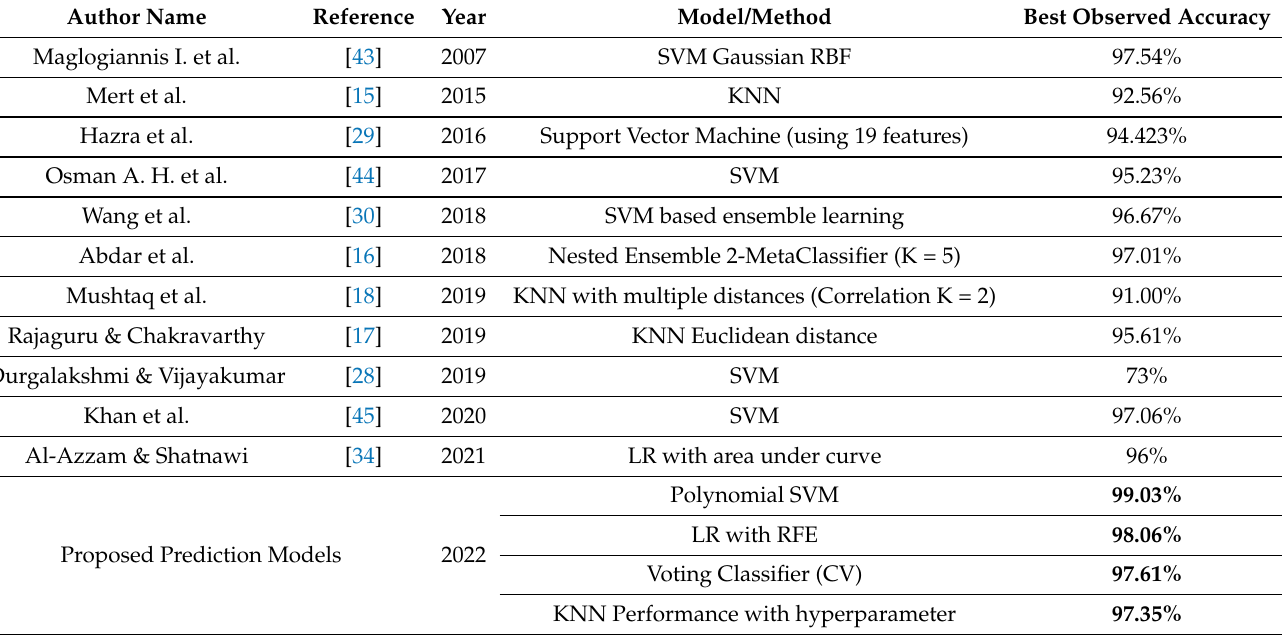
Table 7. Accuracy comparison of our proposed breast cancer prediction models with previous studies that used the same WDBC